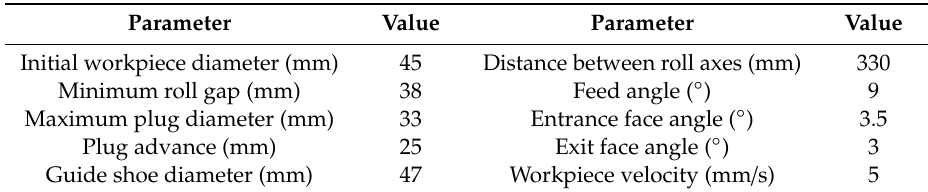
Table 2. Parameters of rotary piercing process.